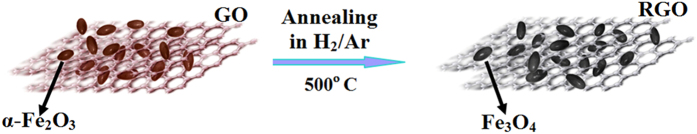
Skeleton of the synthesis process of the Fe3O4/RGO composite.